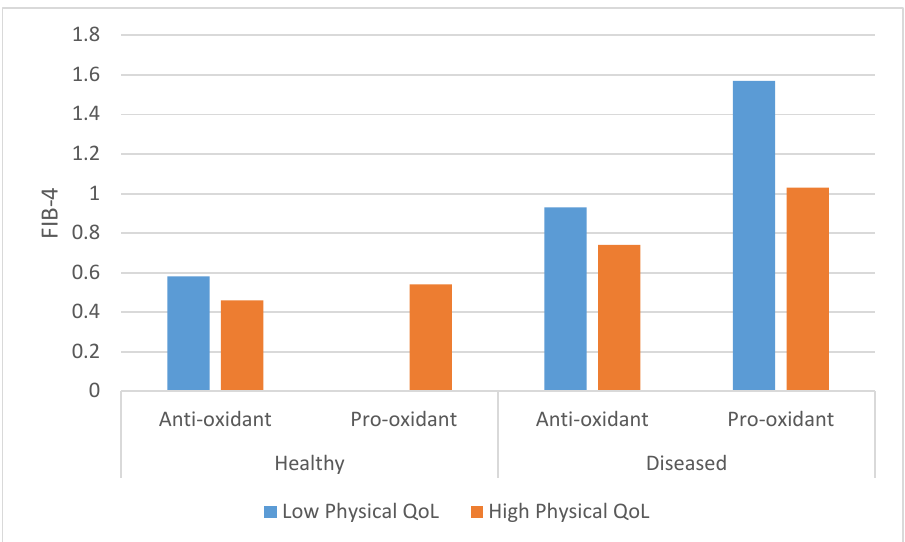
Figure 1. Fibrosis-4 (FIB-4) according to comorbidity, oxidative lifestyle and physical summary quality of life (QoL) SF-36. Antioxidant: Patients with 2 points in pro-oxidant lifestyle vs. rest of the population; Healthy: No diseases; Comorbid: At least 1 disease; Low physical QoL: Lowest tercile of SF-36 Physical summary. Statistical analysis: Comorbidity p = 0.01; Oxidative lifestyle p = 0.04; SF- 36 Physical Summary QoL p = 0.05.